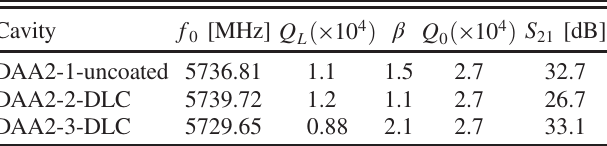
TABLE II. Results of the low-power test conducted using the network analyzer.